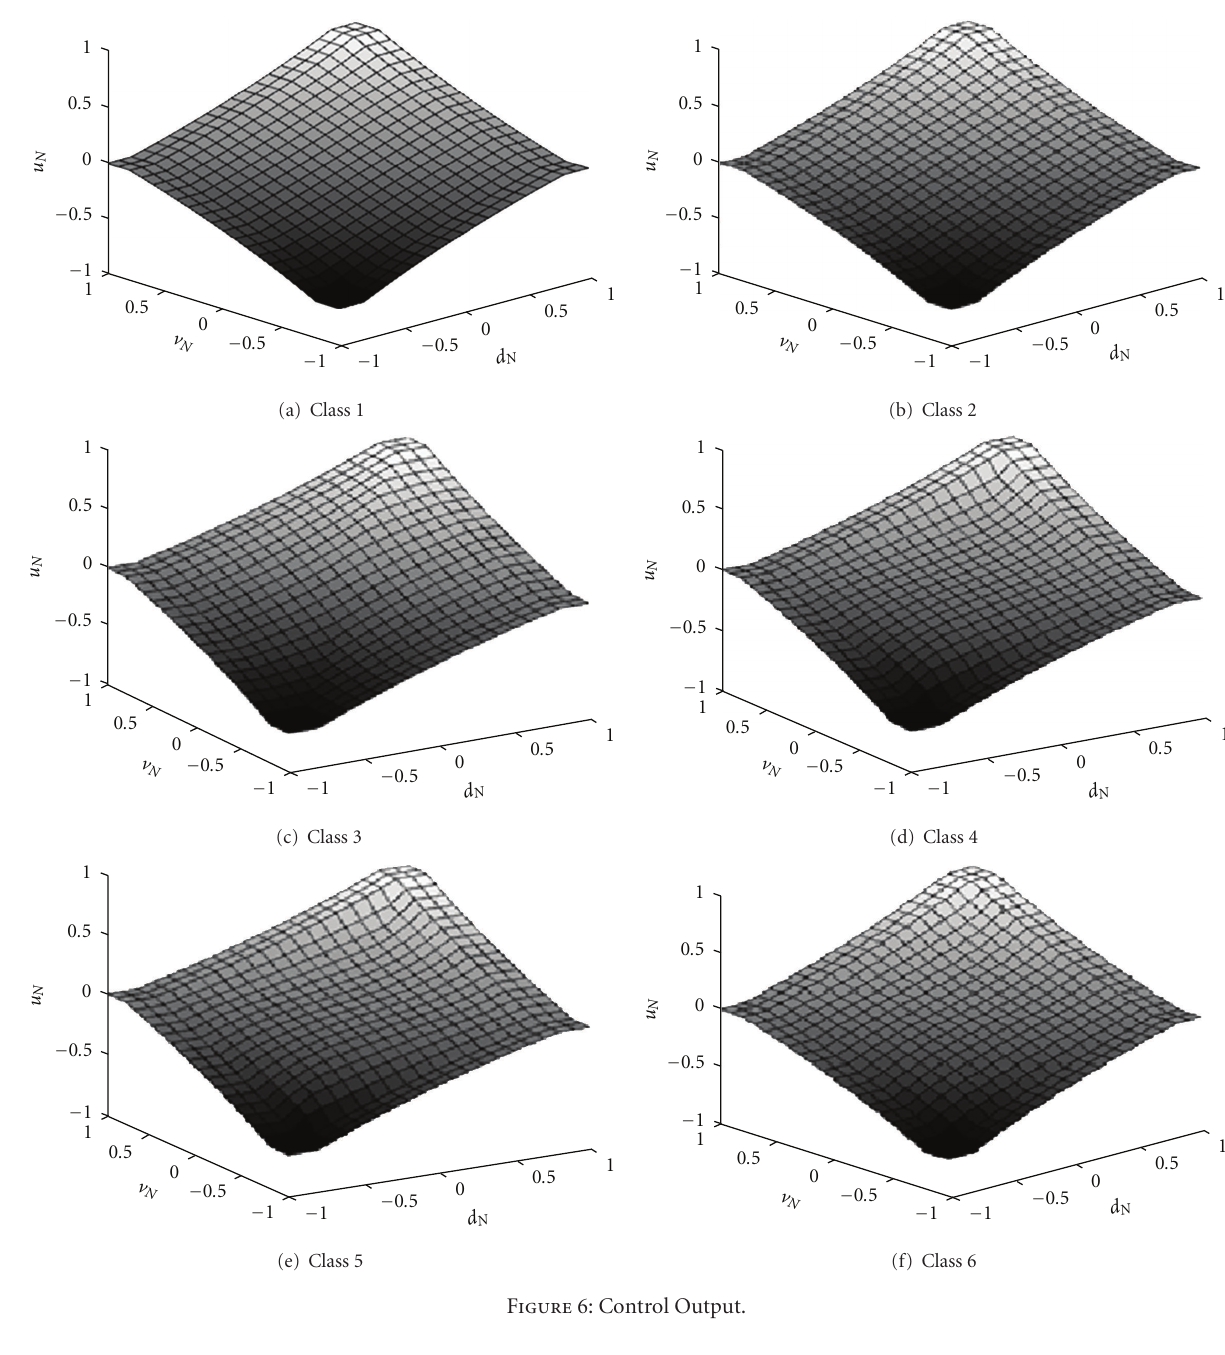
Figure 6: Control